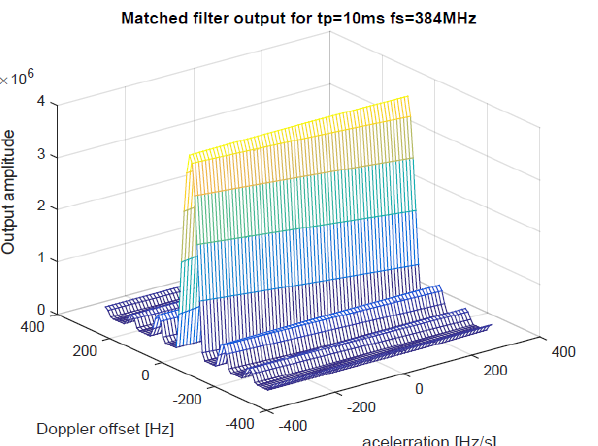
Figure 7– FIR filter outputs for different velocities and accelerations Рис. 7 – Выход КИХ-фильтра при различных скоростях и ускорении